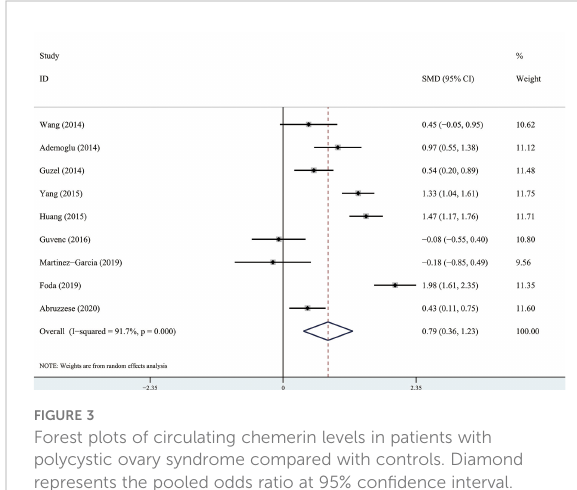
FIGURE 2 Forest plots of circulating apelin levels in patients with polycystic ovary syndrome compared with controls. Diamond represents the pooled odds ratio at 95% con fi dence interval.